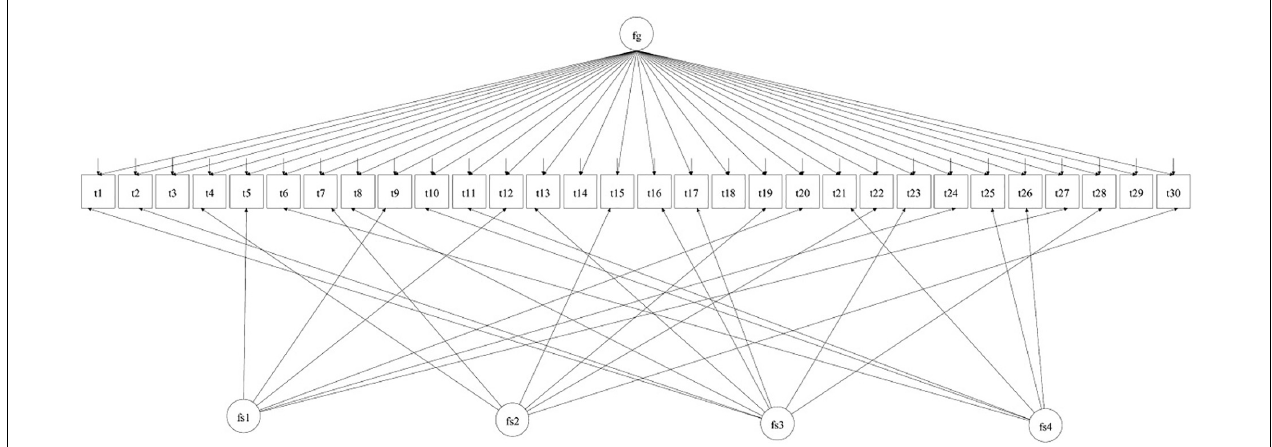
FIGURE 1 | Illustration of the base ESEM bi-factor model tested through measurement invariance analyses across the chosen sociodemographic variables. Fg stands for global trait EI, fsl for well-being, fs2 for self-control, fs3 for emotionality and fs4 for sociability. The TEIQue-SF items are t1 to t30. From “Invariance of the trait emotional intelligence construct across populations and sociodemographic variables” by Pérez-Díaz et al. (2021). Copyright 2021 by the International Society for the Study of Individual Differences